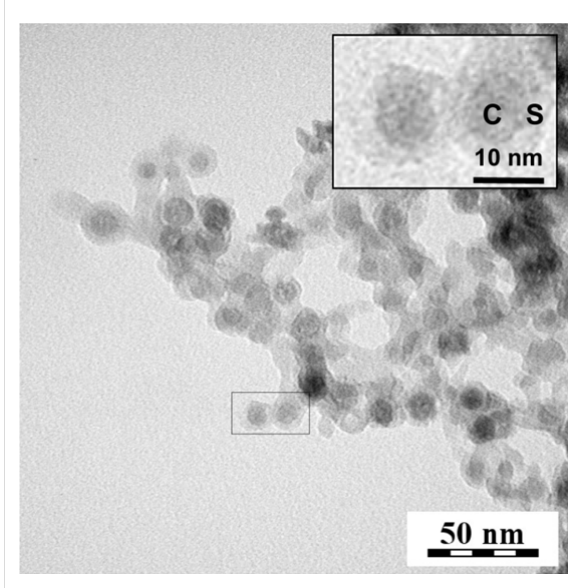
Figure 9: TEM micrograph of NaYF 4 :Yb 3+ /Er 3+ &SiO 2 nanoparticles. Inset: C – particle core and S – SiO 2 shell.